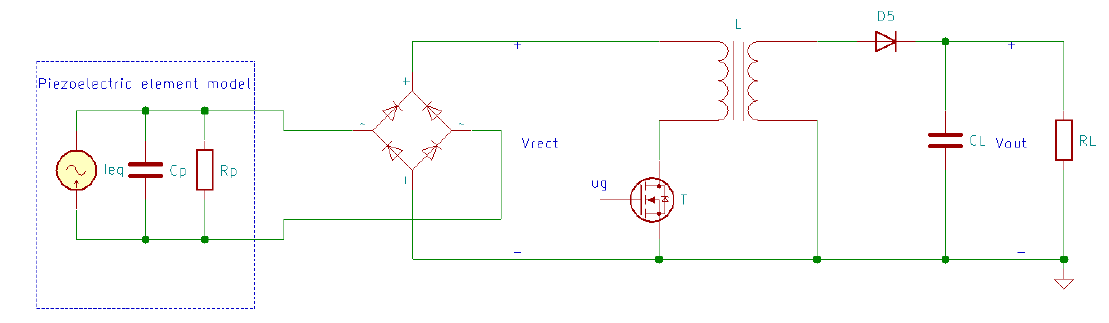
Figure 23. Synchronous Electrical Charge Extraction (SECE) energy harvesting circuit.